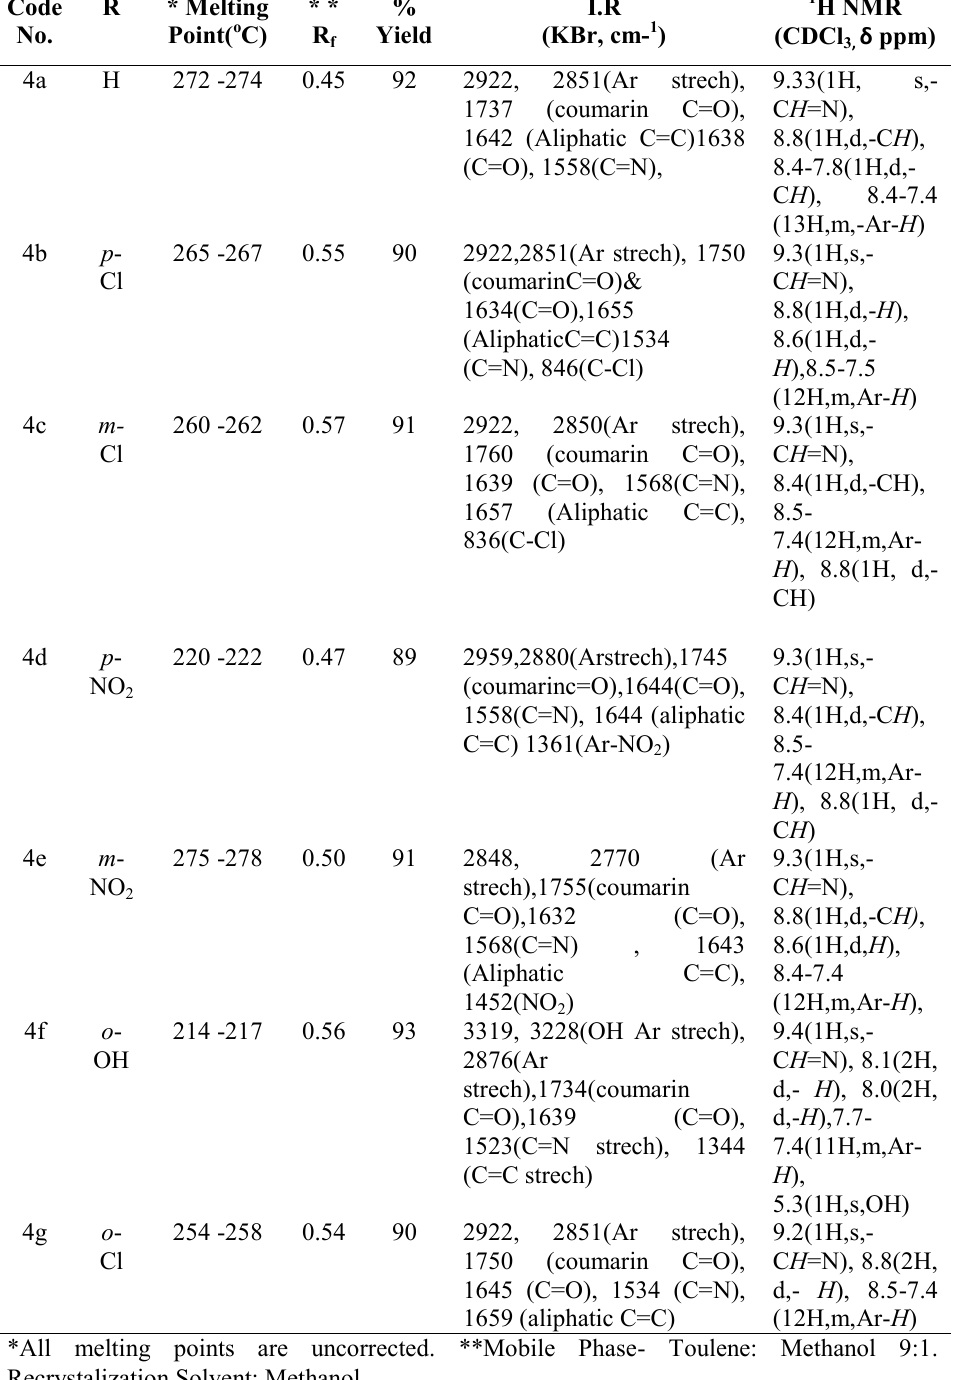
Table I. Physical and spectral data of synthesized